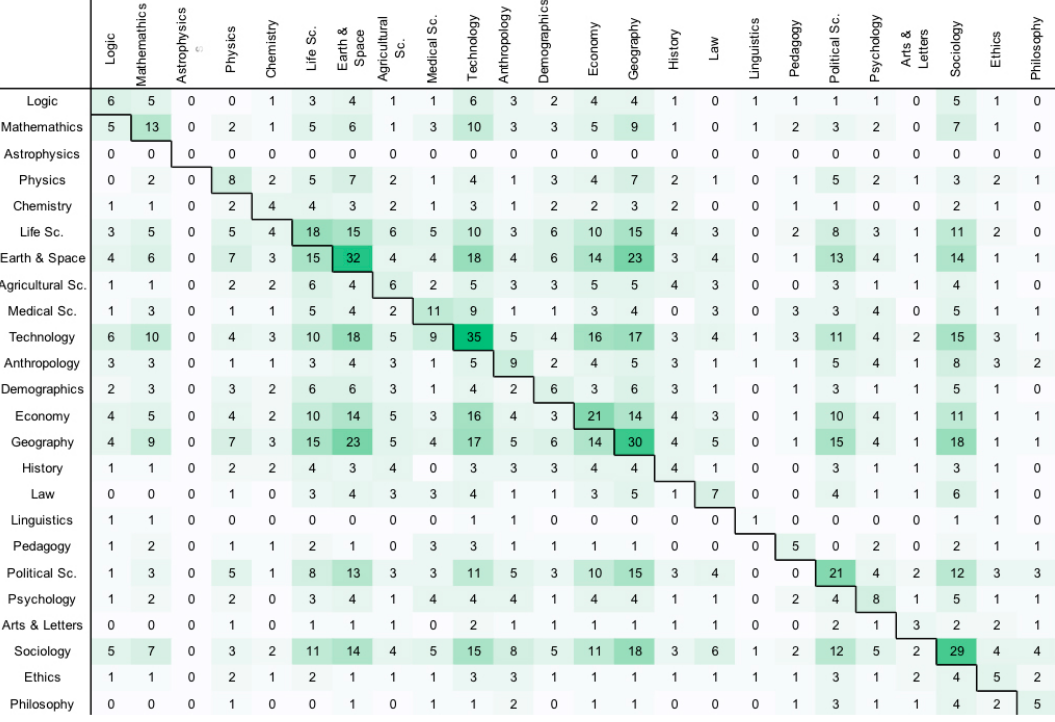
fig. 6. incidence matrix of the different disciplines: higher numbers (darker shading) outside the diagonal indicate a higher occurrence of the two disciplines (row and column) in the same